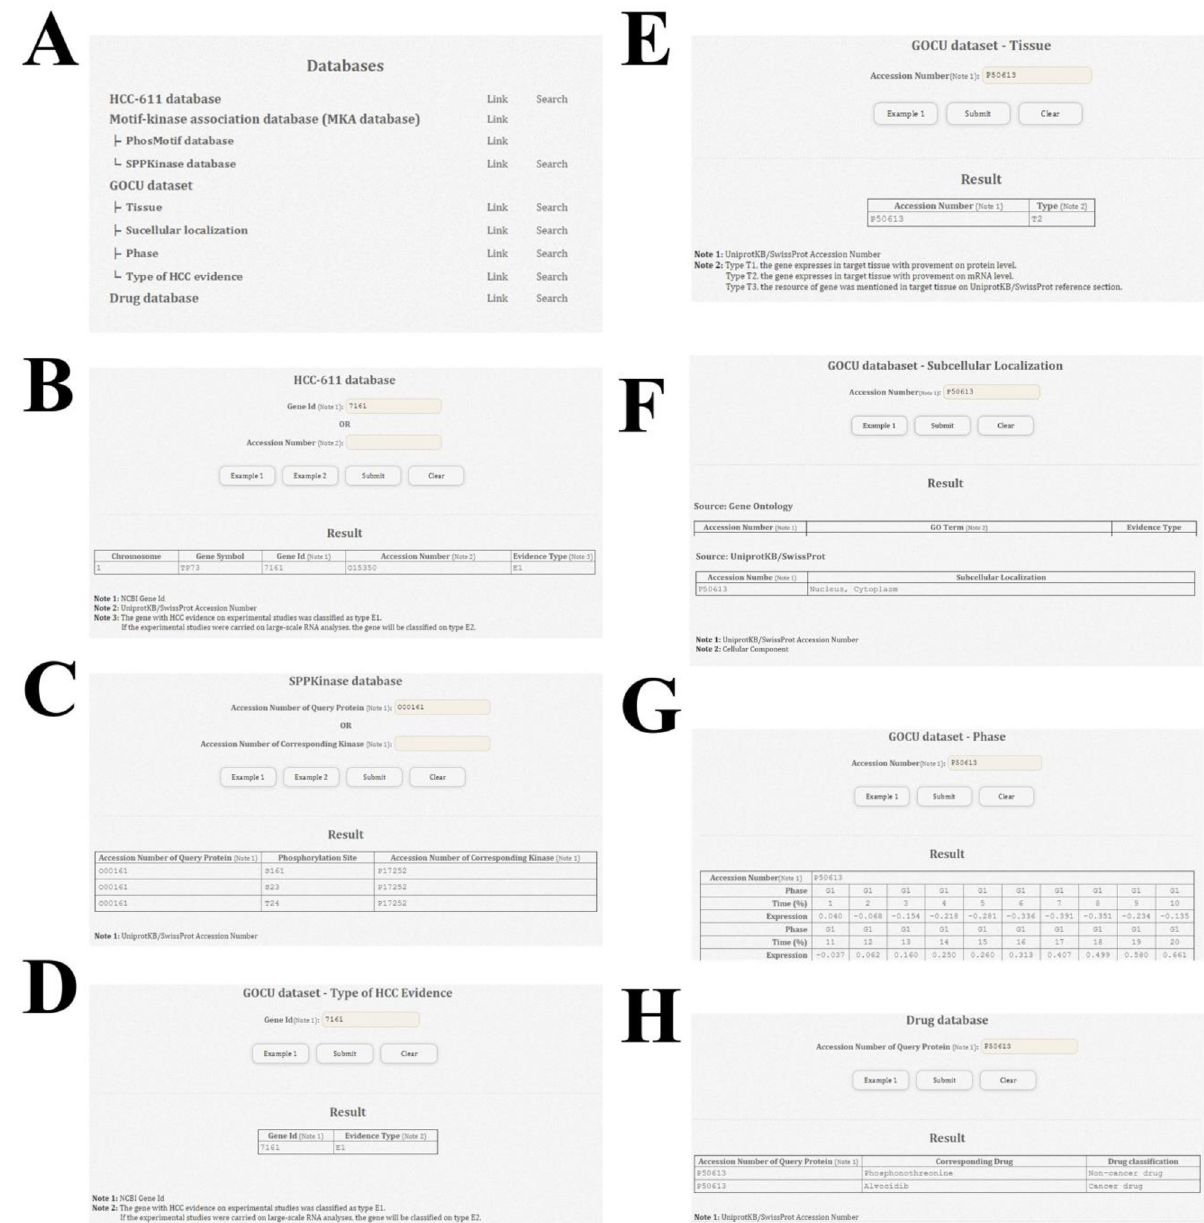
Fig 3. Web interface of search tools and results in the Databases unit of dBMHCC. (A) Web portal of the Databases unit in dBMHCC. dBMHCC contains the HCC-611, MKA, GOCU, and Drug databases and their sub-databases. Users can click Link to download the database information and click Search to investigate the related information for a query protein. (B–H) Web interfaces for the search tools and results from the HCC-611 database (B); the SPPKinase database (C); the type of HCC evidence (D), type of evidence for tissue-specific expression data (E), subcellular localization (F), and phase-specific expression during the cell cycle (G) from the GOCU database; and the Drug database (H).